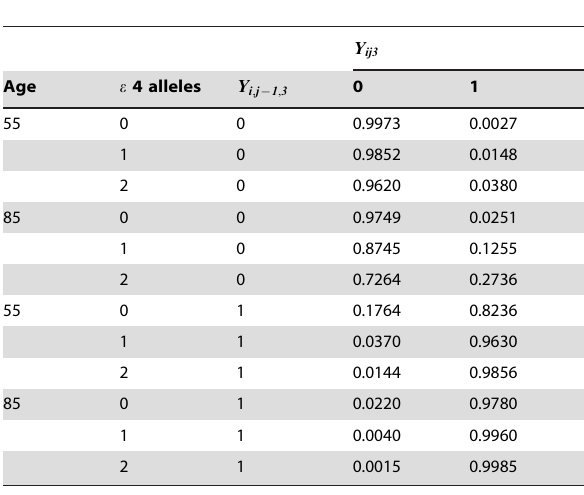
Table 5. The estimated transition probability matrix of binary cognitive status measured by MMSE in Alzheimer’s disease patients at the age of 55 or 85 and carrying no, one, or two APOE- e 4